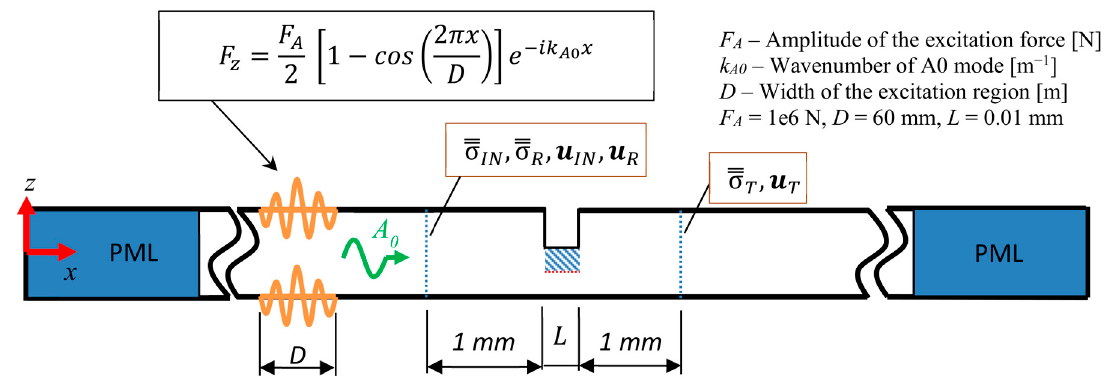
Figure 3. Scattering of Lamb wave at the vertical notch of width L—application of hybrid method. The excitation of the incident A 0 mode was utilized with Hanning-windowed tone- burst in the form of normal force, which was applied on opposite surfaces. It should be noted that the applied excitation on given boundaries is antisymmetric with respect to the mid-plane axis.